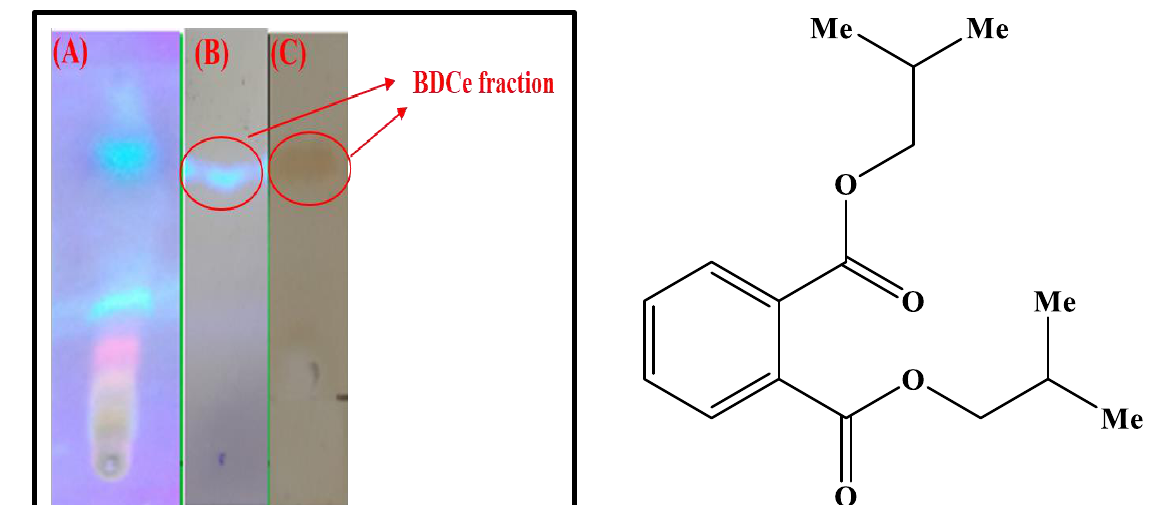
Figure 2. ( A ) Thin layer chromatography of Obea fraction of O. bracteata , ( B ) compound BDCe fraction after column chromatography under 365 nm light, ( C ) BDCe fraction after exposure of iodine (Solvent system = n -hexane: ethyl acetate (7:3)).